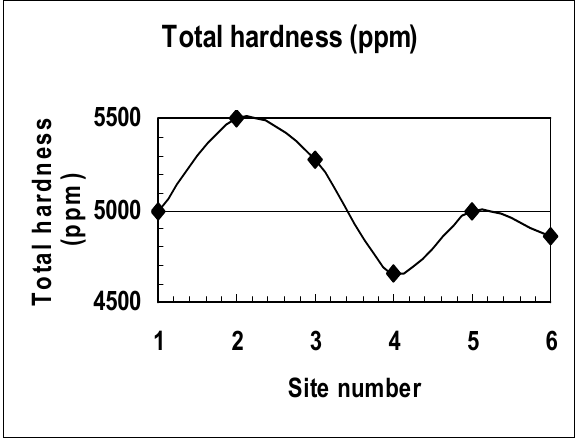
Figure 6 : Variation of total hardness with the site number . The line-diamonds are the experimental